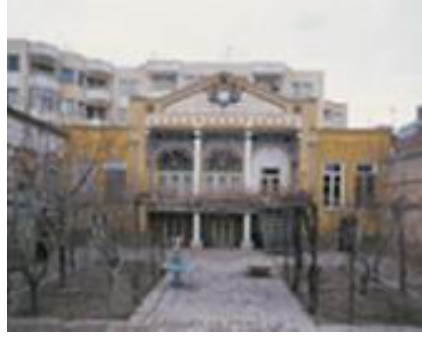
Figure 5 Courtyard house No.4 (Source: Iran Cultural Heritage, Handicrafts and Tourism Organization)